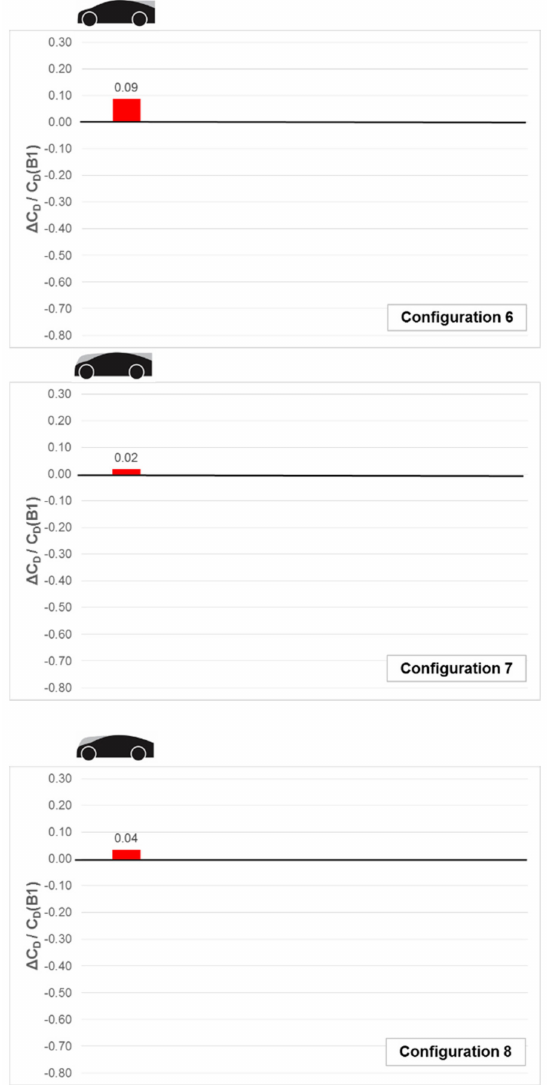
Figure 7. Change in Drag Coefficient ∆ C D between that of the baseline Resnick model (B1) and for the Resnick model when fitted with a backlight add-on B2 (Configuration 6), nose and backlight add-ons B3 (Configuration 7) and nose add-on B4 (Configuration 8), after [50] © SAE International